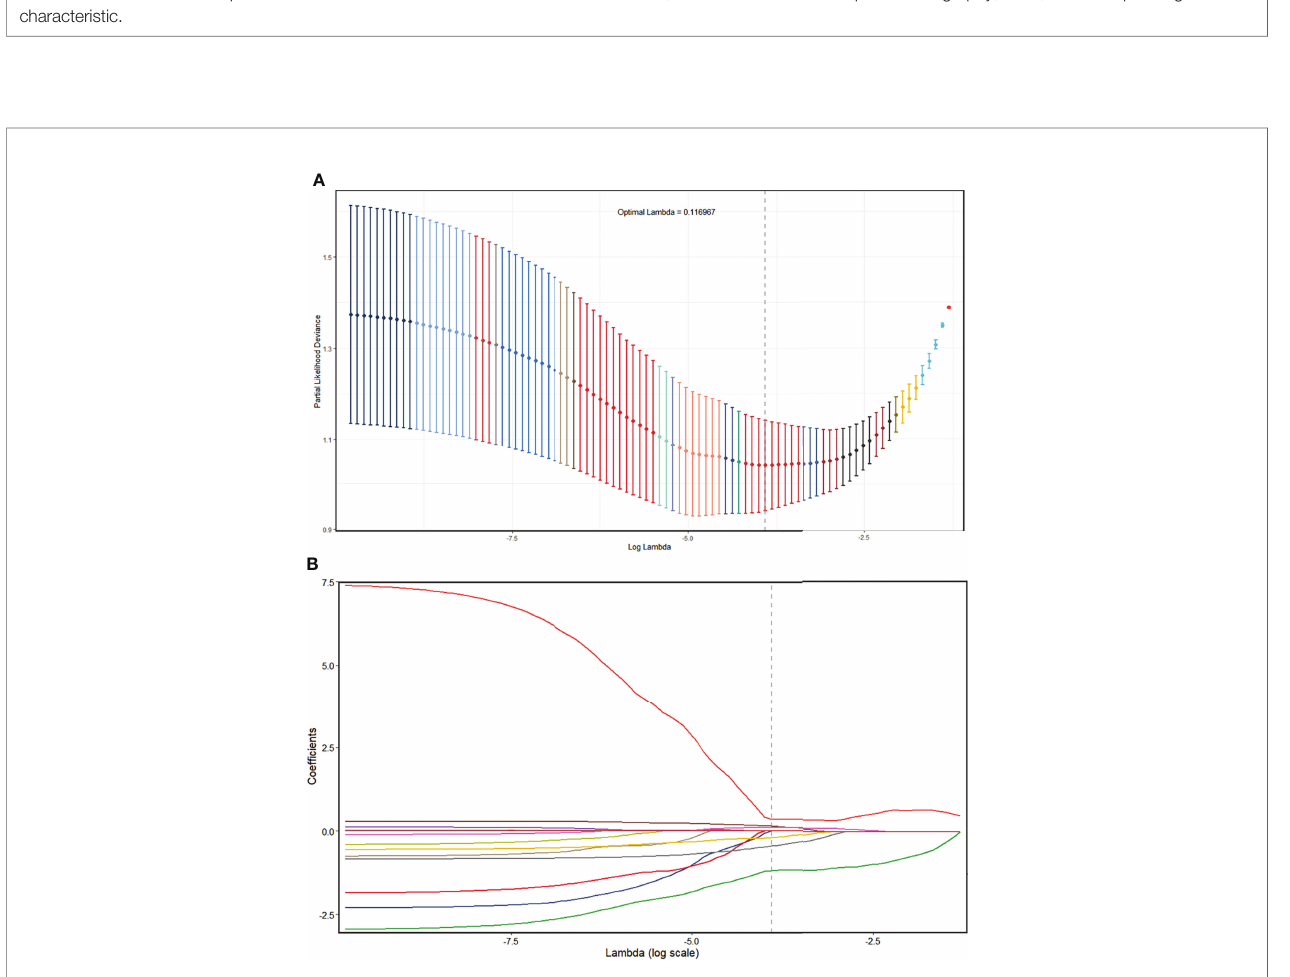
FIGURE 4 | Radiomics feature selection using the LASSO regression model in the UECT model. (A) The partial likelihood deviance from the LASSO regression cross-validation procedure was plotted against log( l ). The optimal l value of 0.116967 was selected. (B) LASSO coef fi cient pro fi les of the radiomics features. As the tuning parameter ( l ) increased using 10-fold cross-validation, more coef fi cients tended to approach 0 and the optimal non-zero coef fi cients were generated, which yielded a set of the optimal radiomics features. LASSO, least absolute shrinkage and selection operator; UECT, unenhanced computed